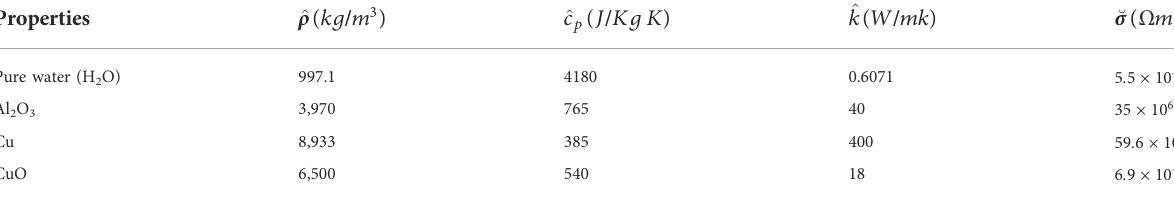
TABLE 5 Thermophysical values of the guest nanoparticles and the host liquid.